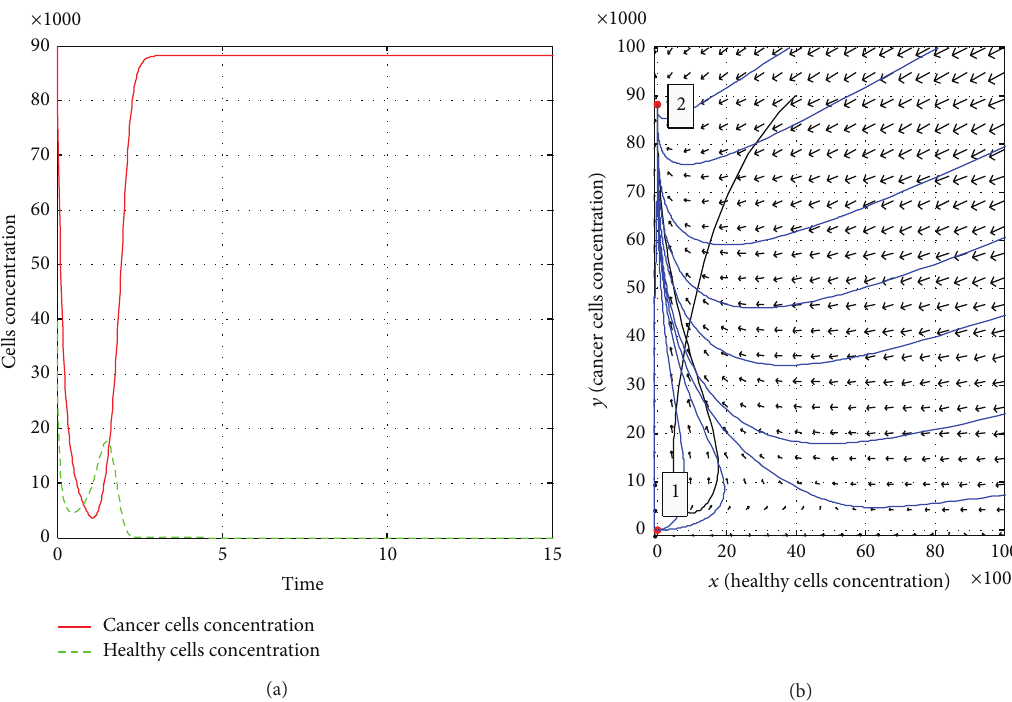
Figure 3: The behavior of the system during finite duration chemotherapy without vaccine therapy: (a) the time evolution of the system; (b) trajectory pattern of the system and system response without vaccine